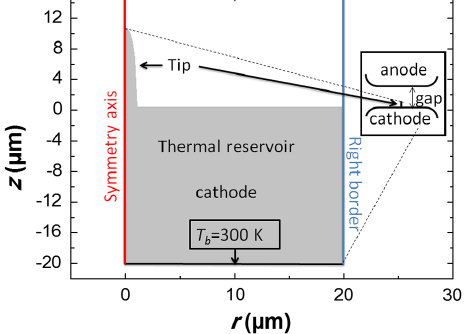
FIG. 3. Magnification of the vicinity of the tip taken with an elliptic shape. The tip is represented with its thermal reservoir (thermostat) which is the cathode. The inset shows the interelec- trode gap (the size of the tip is not to scale).